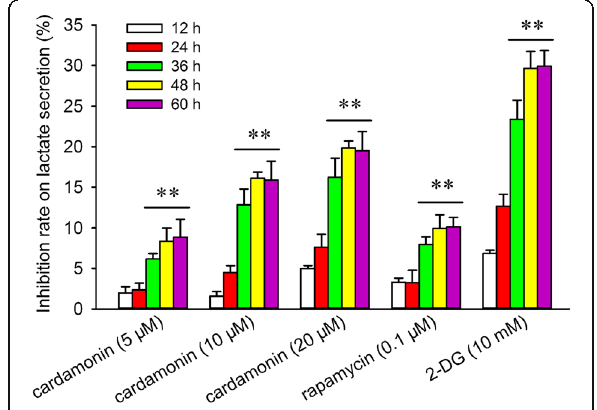
Fig. 1 Cardamonin inhibited lactate secretion. SKOV3 cells were treated with cardamonin (5, 10, 20 μ M), rapamycin (0.1 μ M) and 2- DG (10 mM) for 24, 36, 48, 60 and 72 h. Lactate secretion was analyzed by an assay kit. Inhibition Rate = (1 - drug group/control × 100%). ** p < 0.01 vs. 24 h. Data were represented as mean ± SD, n =